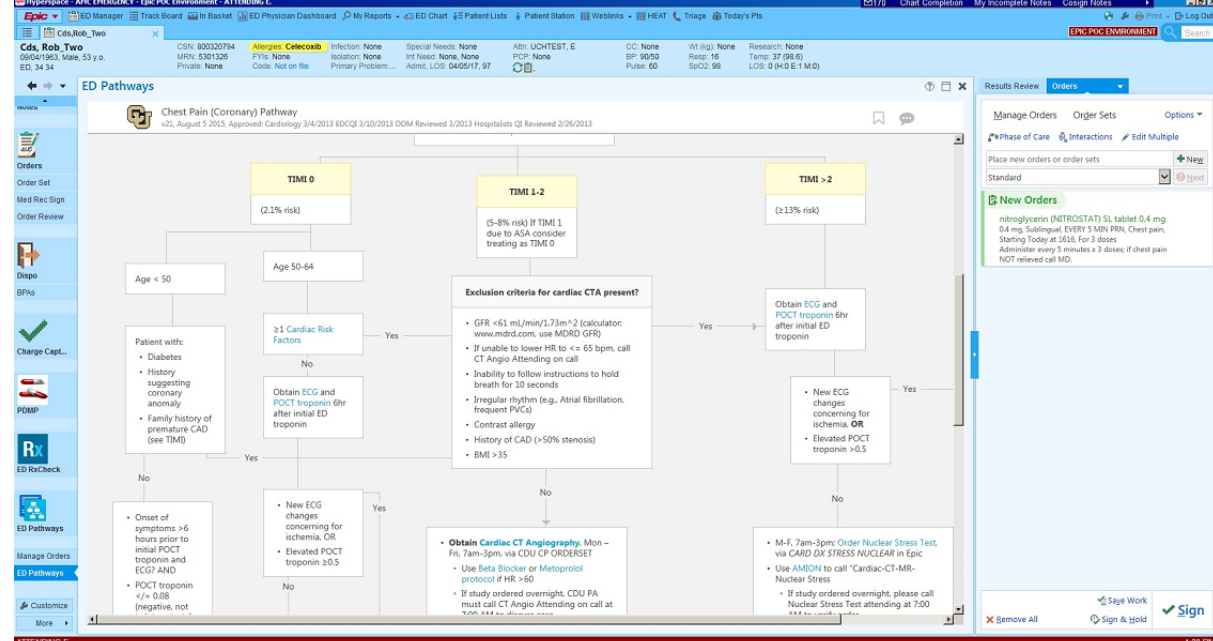
Figure 1. Example of an encounter-level care pathway clinical decision support application using synthetic patient